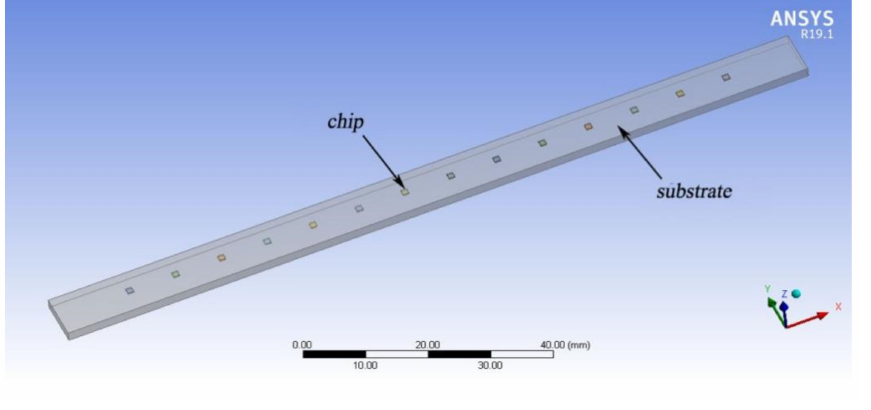
Figure 1. Model package of the LED